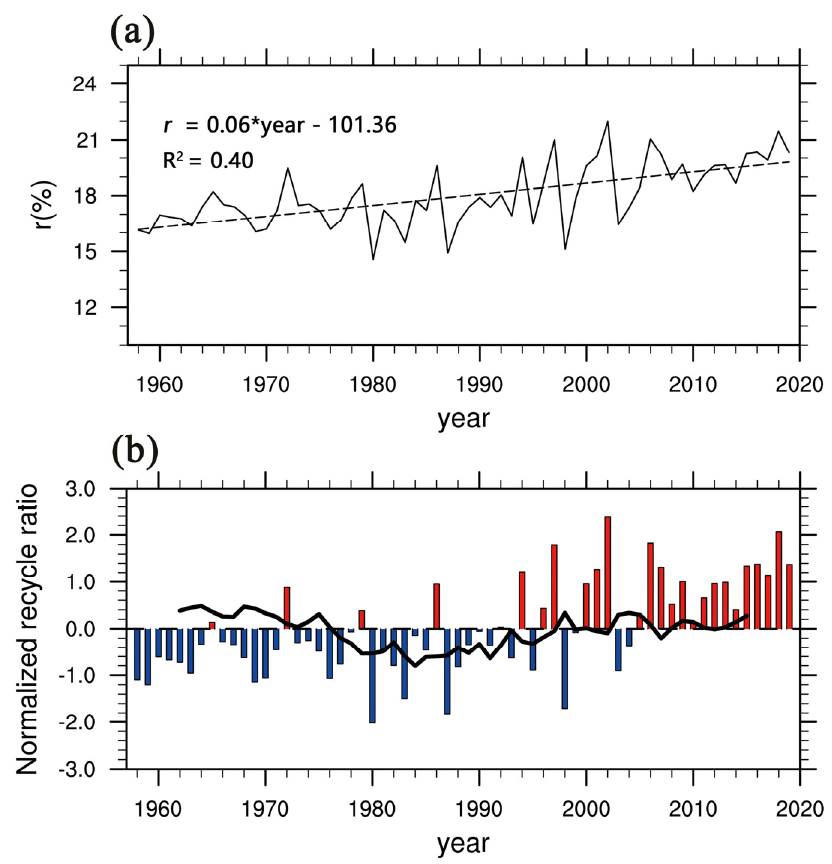
Figure 7. Time series of PRR on the TP ( a ), and its standardized series ( b ). When the WVB was strong, the multi-year average PRR was 17%, and for the weak years, the PRR was 19%, the difference of the PRRs between strong and weak years was 2%. In particular, for the atmospheric water cycle elements of the adjacent weak and strong years of 1997/1998, the TP’s summer WVB was 48.41/83.23 × 10 6 kg s − 1 , the total water vapor input was 152.28/233.27 × 10 6 kg s − 1 , and the corresponding precipitation was 145.11/185.64 × 10 6 kg s − 1 ; the evapotranspiration was 80.94/83.09 × 10 6 kg s − 1 , the PRR was 21/15%, and the difference of PRR between strong and weak years was 6%, indicating that the contribution of local evaporative to precipitation on the TP is especially important. It can be concluded that when the WVT on the TP increases (decreases), the precipitation and evapotranspiration increase (decrease), but the ratio of evapotranspiration to precip- itation decreases (increases), and the PRR decreases (increases). Next, we calculated the climatic state and the combined PRRs of the strong year and the weak year of the 13 basins in the TP. It can be seen from Table 4 that the PRR in the Indus River Basin is the largest (12%), followed by the Qiangtang Plateau (11%), and only these two basins exceeded 10%; followed by the Yellow River, Amu Darya, Yangtze River, and the Yarlung Zangbo River Basin (7~10%); then by the Qaidam Basin, Tarim River, and Hexi River Basins (5~6%); and finally the Ganges, Nu Jiang River, Lancang River, and Irrawaddy River Basins (<5%). We found that the Yarlung Zangbo River Basin has a large WVB and total input, resulting in a relatively low PRR; the Qiangtang Plateau has a rela- tively large PRR due to large evapotranspiration; and the Indus River Basin has a rela- tively high WVB . However, the river basins of Ganges, Nu Jiang River, Lancang River, and Irrawaddy River were small in area; although the WVB was relatively small, the total water vapor input was relatively large, which made the PRR of these river basins small.